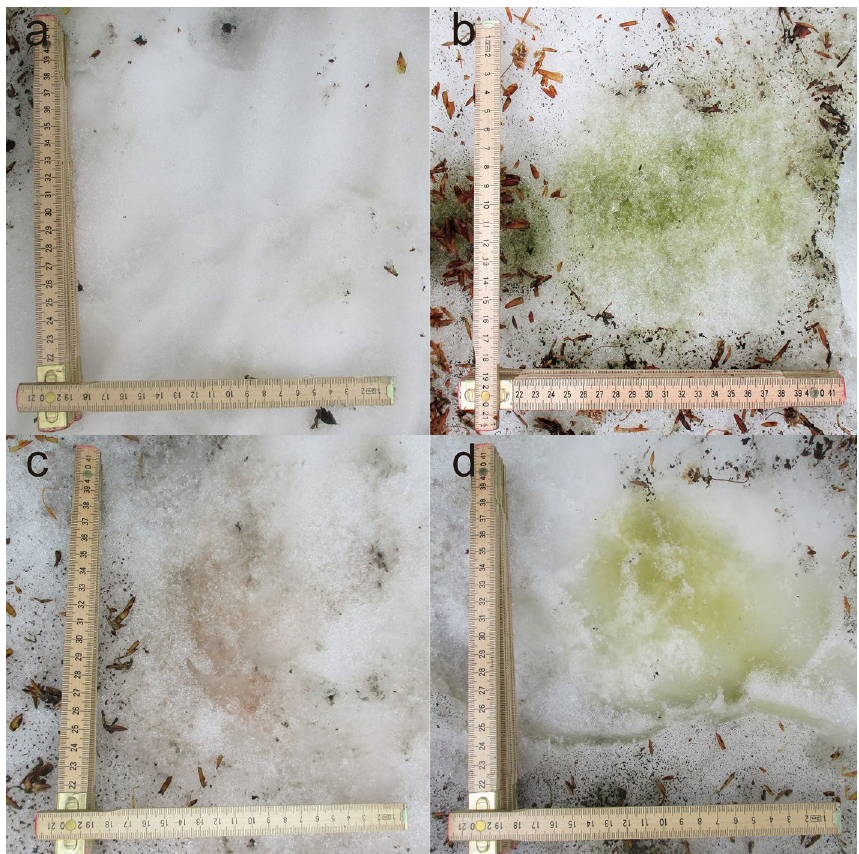
Figure 2. Snow surface collected in 2018. ( a ) White snow, ( b ) green snow, ( c ) orange snow, ( d ) golden-brown snow.